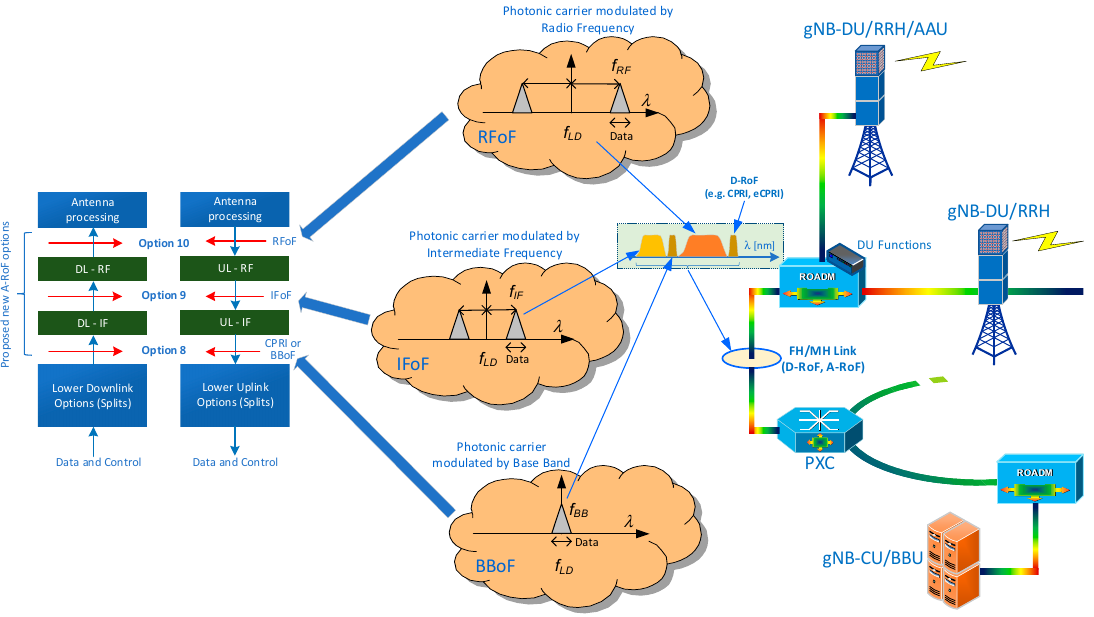
Figure 8. Proposition of new Options (Splits) for realization of analog interfaces working in A-RoF techniques. Splits mainly used for fronthaul/midhaul to connect DU and AAU (as a gNB-DU)—simple A-DAS.